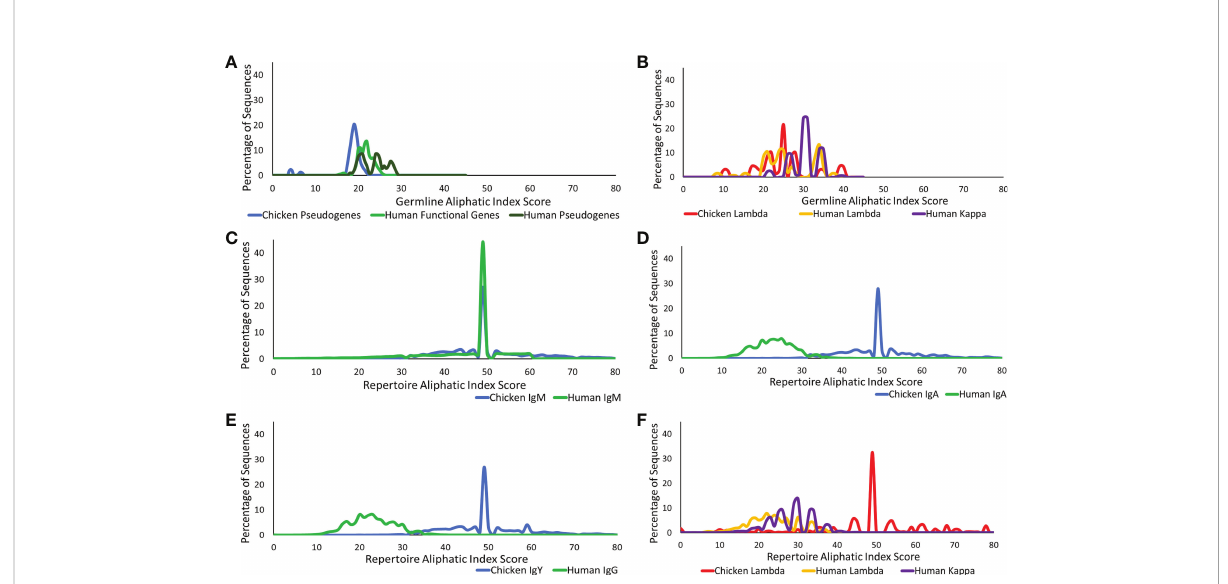
FIGURE 6 Aliphatic index comparison of germline variable genes between (A) chicken pseudogenes, human functional genes, and human pseudogenes at the heavy chain loci and (B) chicken pseudogenes, human lambda functional genes, and human kappa functional genes at the light chain loci. Comparison of the aliphatic index between repertoire sequences shows (C) chicken IgM against human IgM, (D) chicken IgA against human IgA, (E) chicken IgY against human IgG, and (F) chicken lambda light chain sequences against human lambda light chain sequences and